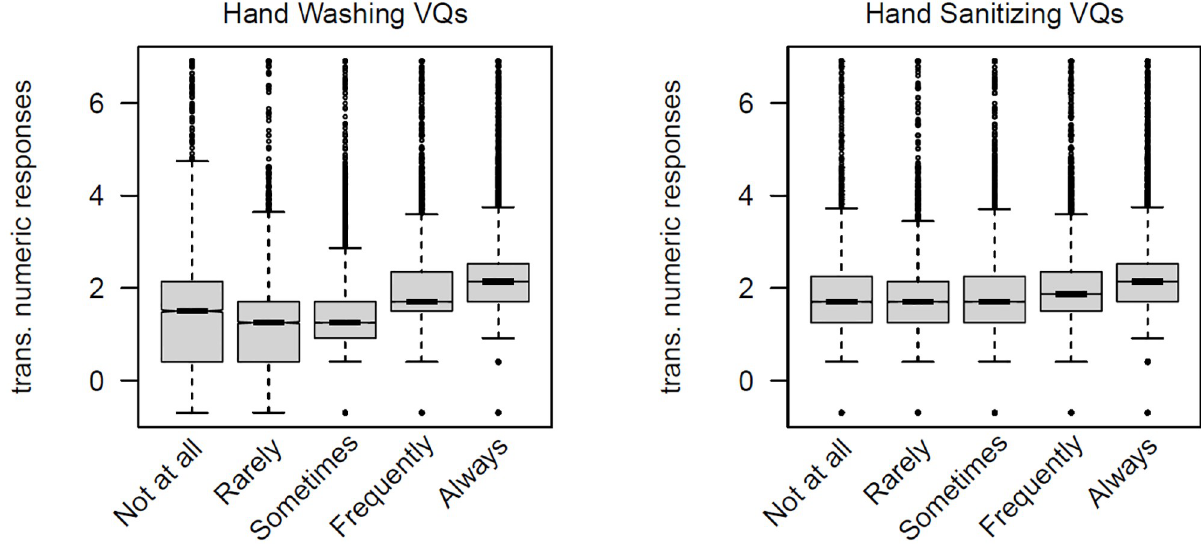
Fig 1. Boxplots for the transformed numeric response from the free recall question for the two vague quantifier questions.